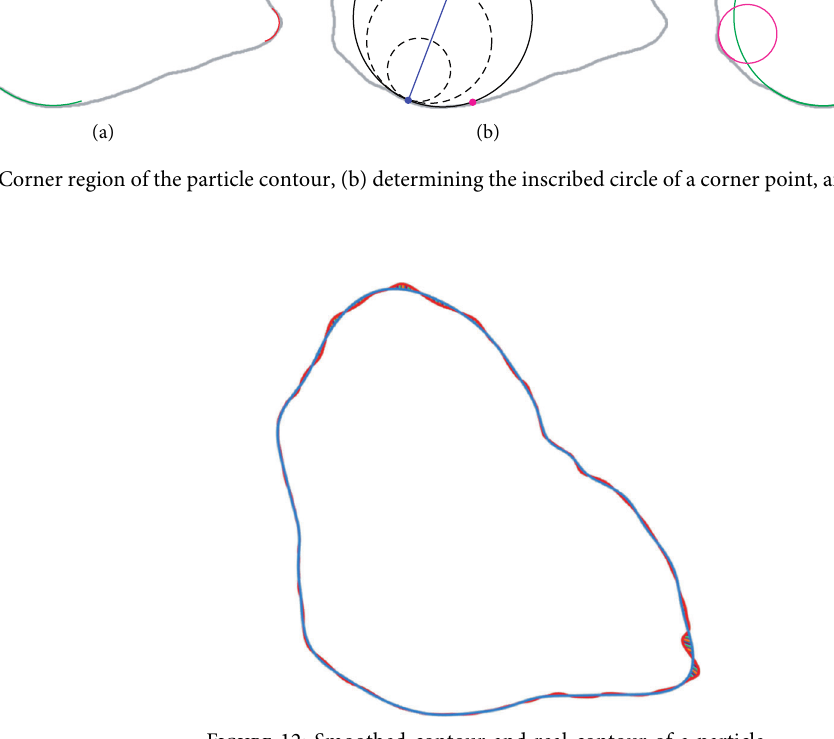
Figure 12: Smoothed contour and real contour of a